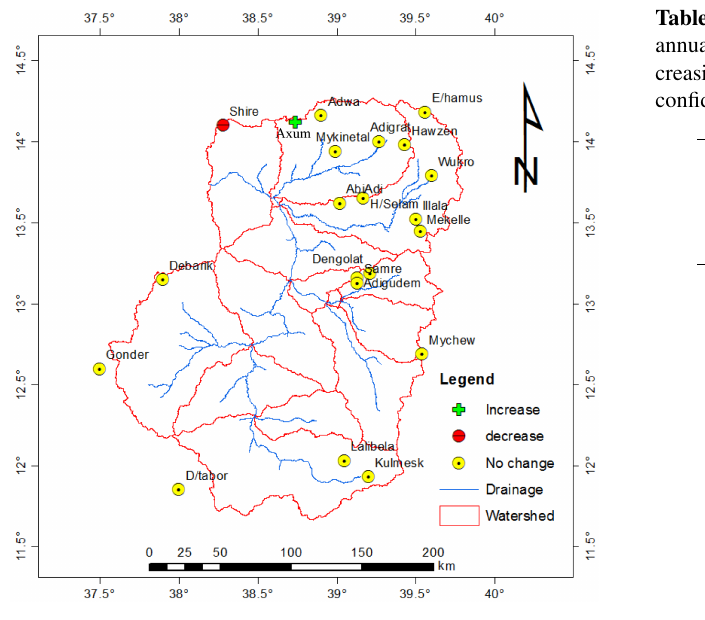
Figure 3. Location of rainfall stations with increasing ( + ), decreas- ing ( − ) and no-change (0) trends on annual rainfall.